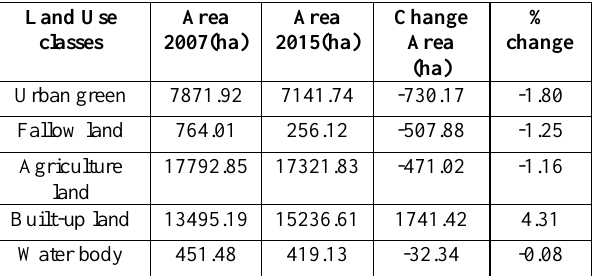
Table 3: Land Use Change (2008-2015)